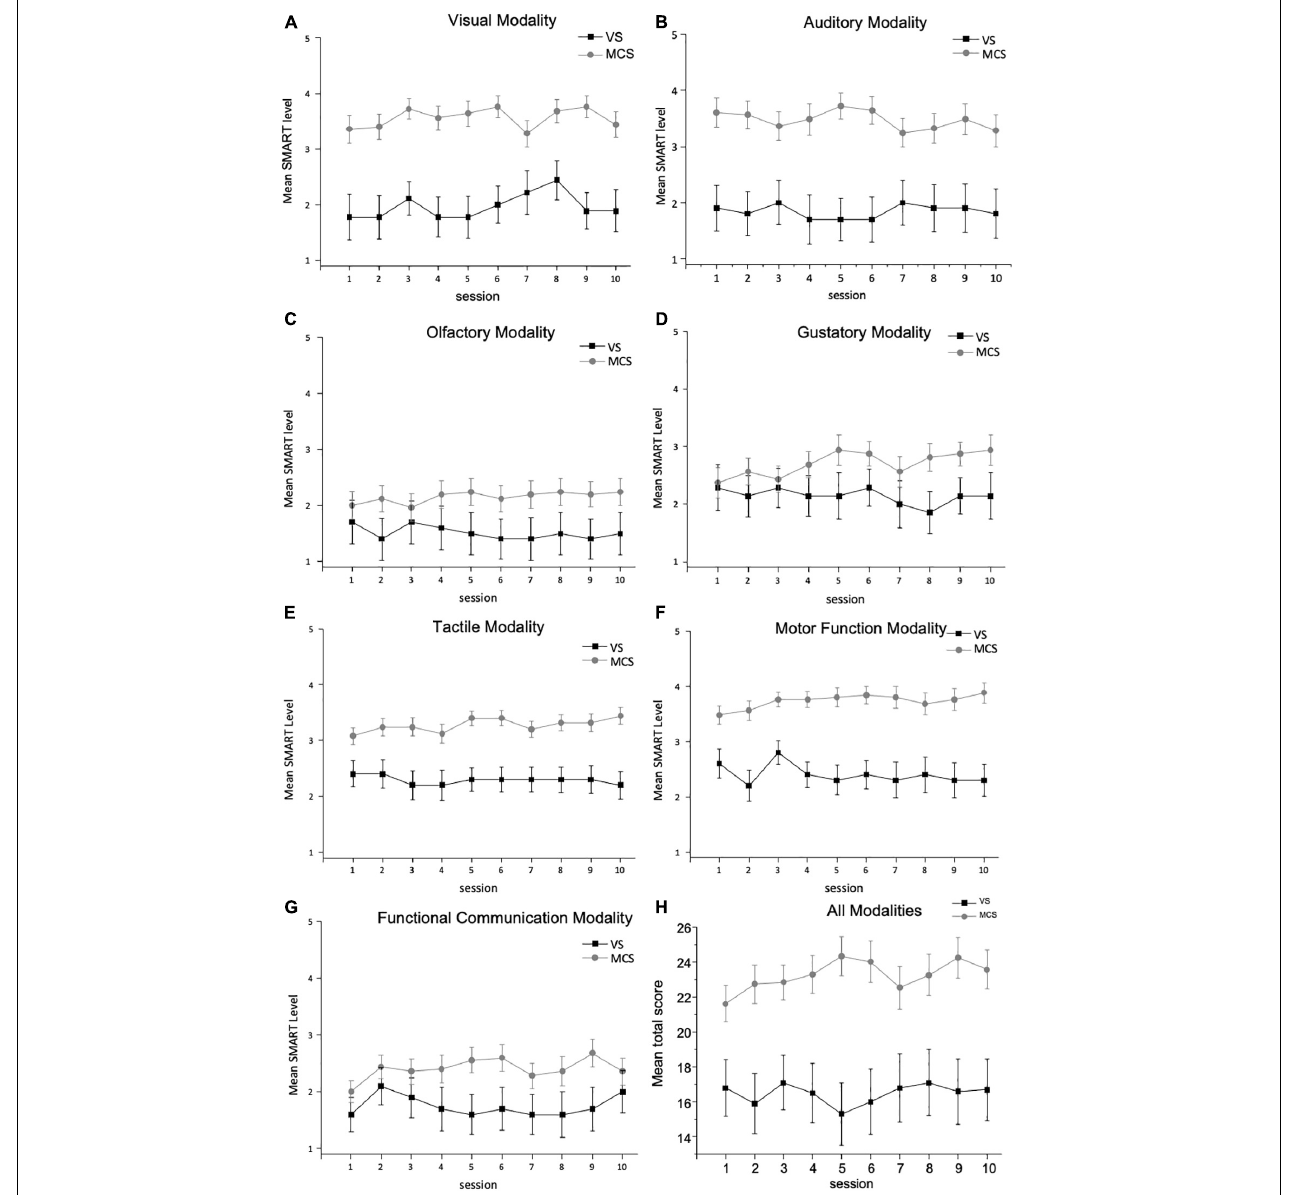
FIGURE 1 | Mean SMART level per diagnosis group ± SEM: (A) mean SMART level for VS and MCS groups for the visual modality ± SEM; (B) mean SMART level for VS and MCS groups for the auditory modality ± SEM; (C) mean SMART level for VS and MCS groups for the olfactory modality ± SEM; (D) mean SMART level for VS and MCS groups for the gustatory modality ± SEM; (E) mean SMART level for VS and MCS groups for the tactile modality ± SEM; (F) mean SMART level for VS and MCS groups for the motor function modality ± SEM; (G) mean SMART level for VS and MCS groups for the functional communication modality ± SEM; and (H) mean SMART level for VS and MCS groups for total score of all modalities ±